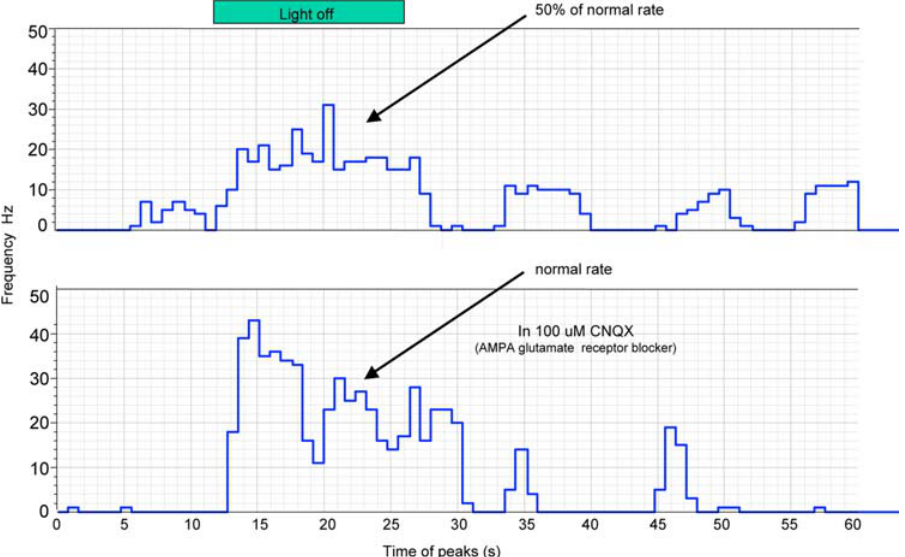
Figure 4. Physiological characterization of the curly mutation. Two graphs showing the effect of CNQX on the frequency of larval swimming. The histograms represent the mean frequency in 10 s bins of spikes before, during and after a light off stimulus. (Table 4): VC and CDS sampling sites showed elevated levels of gene flow (Table 4, Nm=4.76) and they were found to share both identical alleles for more than one locus and identical individual were found to be significantly distinct from one another.